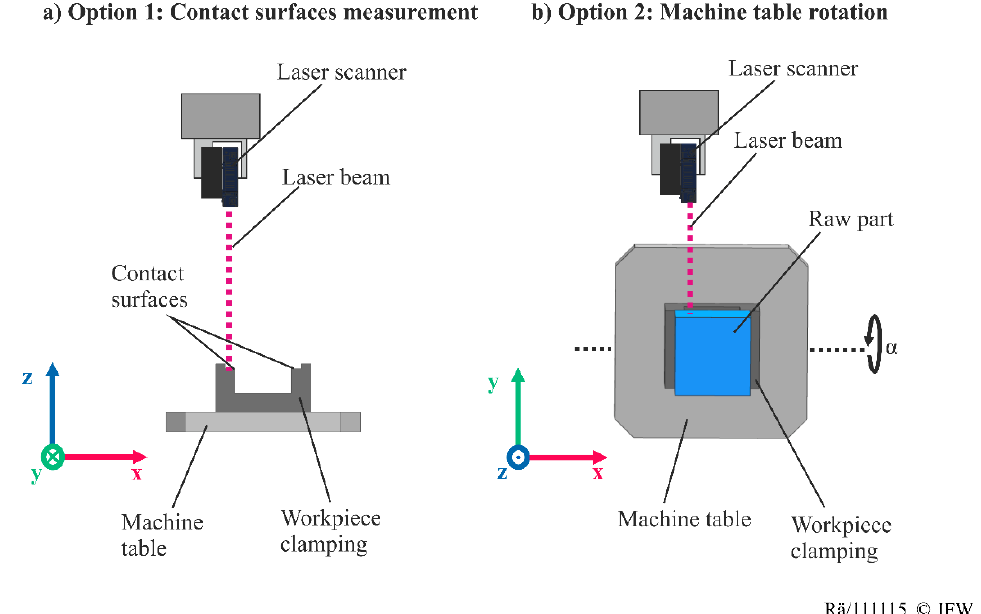
Figure 11. ( a , b ) Options for the height measurement of a raw part.